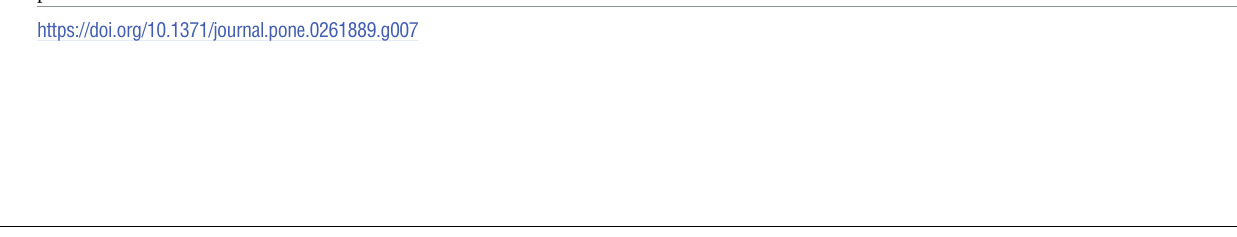
PLOS ONE | https://doi.org/10.1371/journal.pone.0261889 December29,